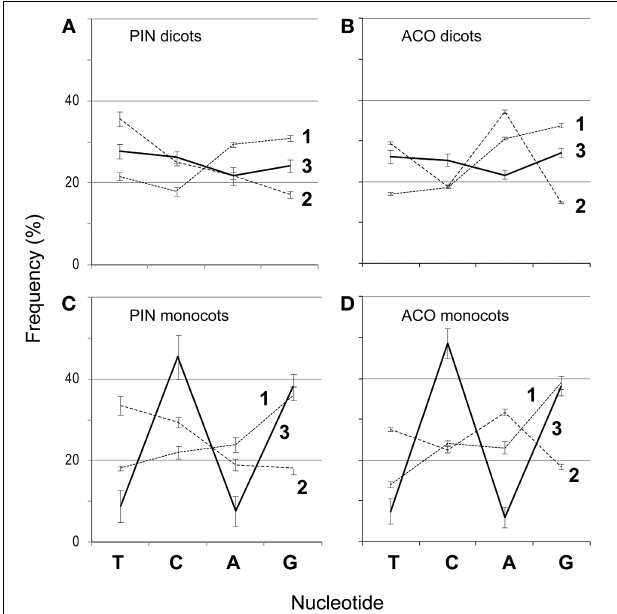
FIGURE 2 | Frequencies of nucleotides (T, C, A, and G) at each codon position (1–3) for 151 PIN and 193 ACO genes in dicots (A,B), and monocots (C,D). Bars represent 95% confidence intervals.